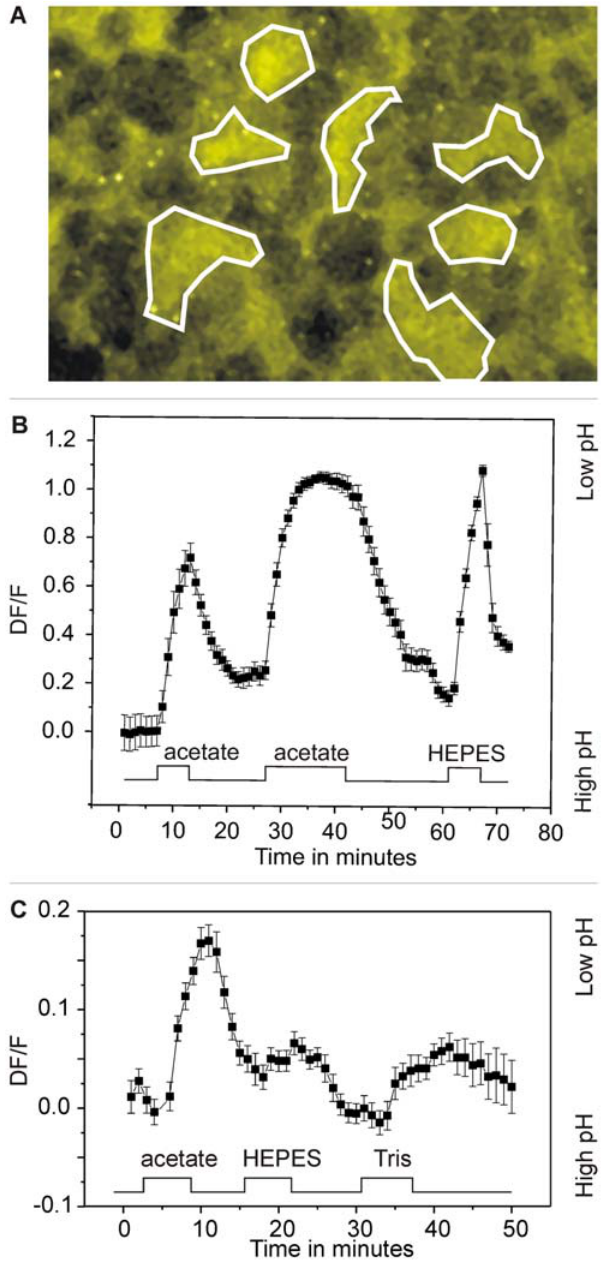
Figure 5. HEPES and Tris lead to intracellular acidification in the isolated retina of goldfish. A , BCECF fluorescenceof horizontal cells in the flat mounted retina in control conditions. Horizontal cells stain yellow. BandC , D F/F as function of time. Data points arethe average of 7 cells (regions of interest) and error bars represent sem. Increase in fluorescence signal indicates acidification. Complete exchange of solution in recording chamber took about 2 minutes. Frames were sampled every 2 minutes. Application of 25 mM acetate, 20 mM HEPES and 20 mM TRIS all lead to a reduction of intracellular pH.